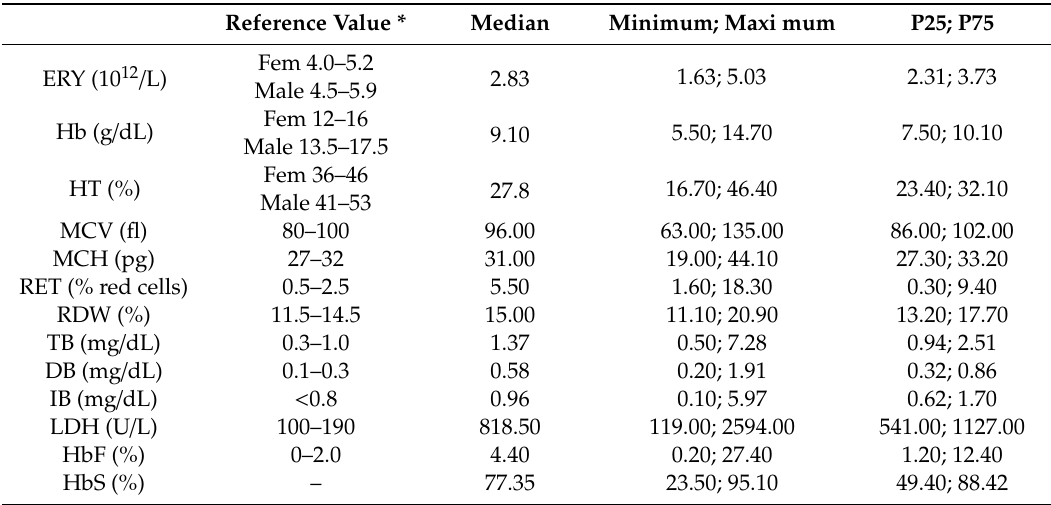
Table 2. Hematological parameters in adult sickle cell disease patients ( n = 51).